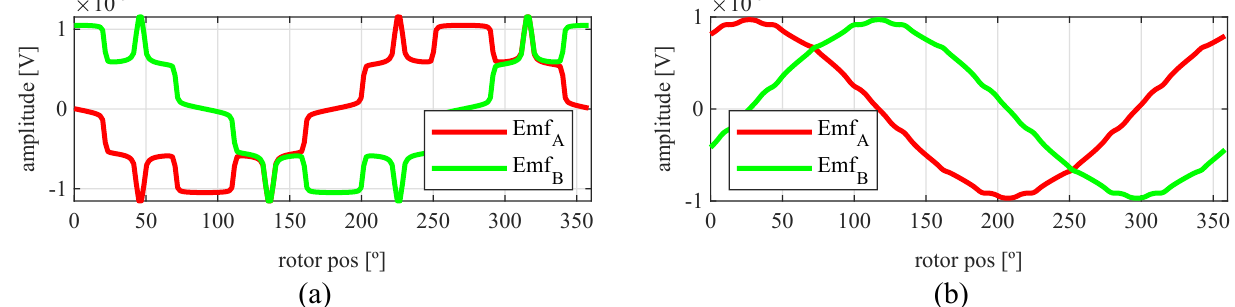
Figure 18. Toroidal four-slot resolver EMFs skewed for the least THD ( a ) before skew and ( b ) with skew.